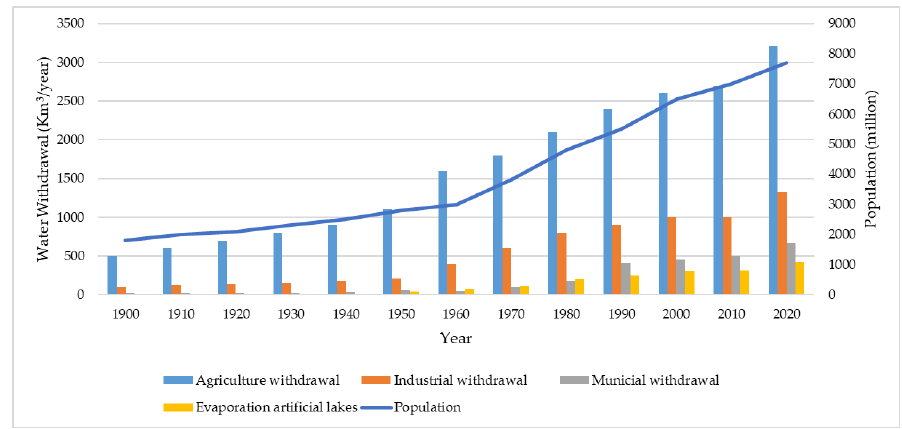
Figure 2. Global population and water withdrawal over time.